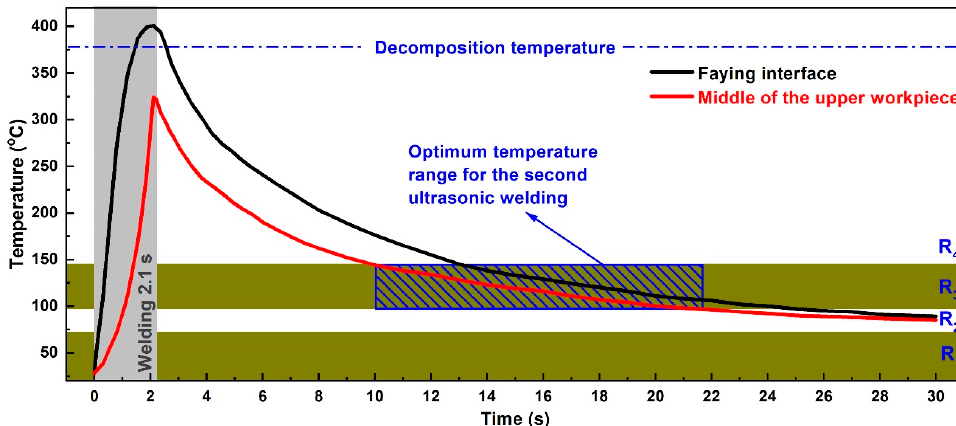
Figure 3. Temperature evolutions at the faying interface and middle of upper workpiece for